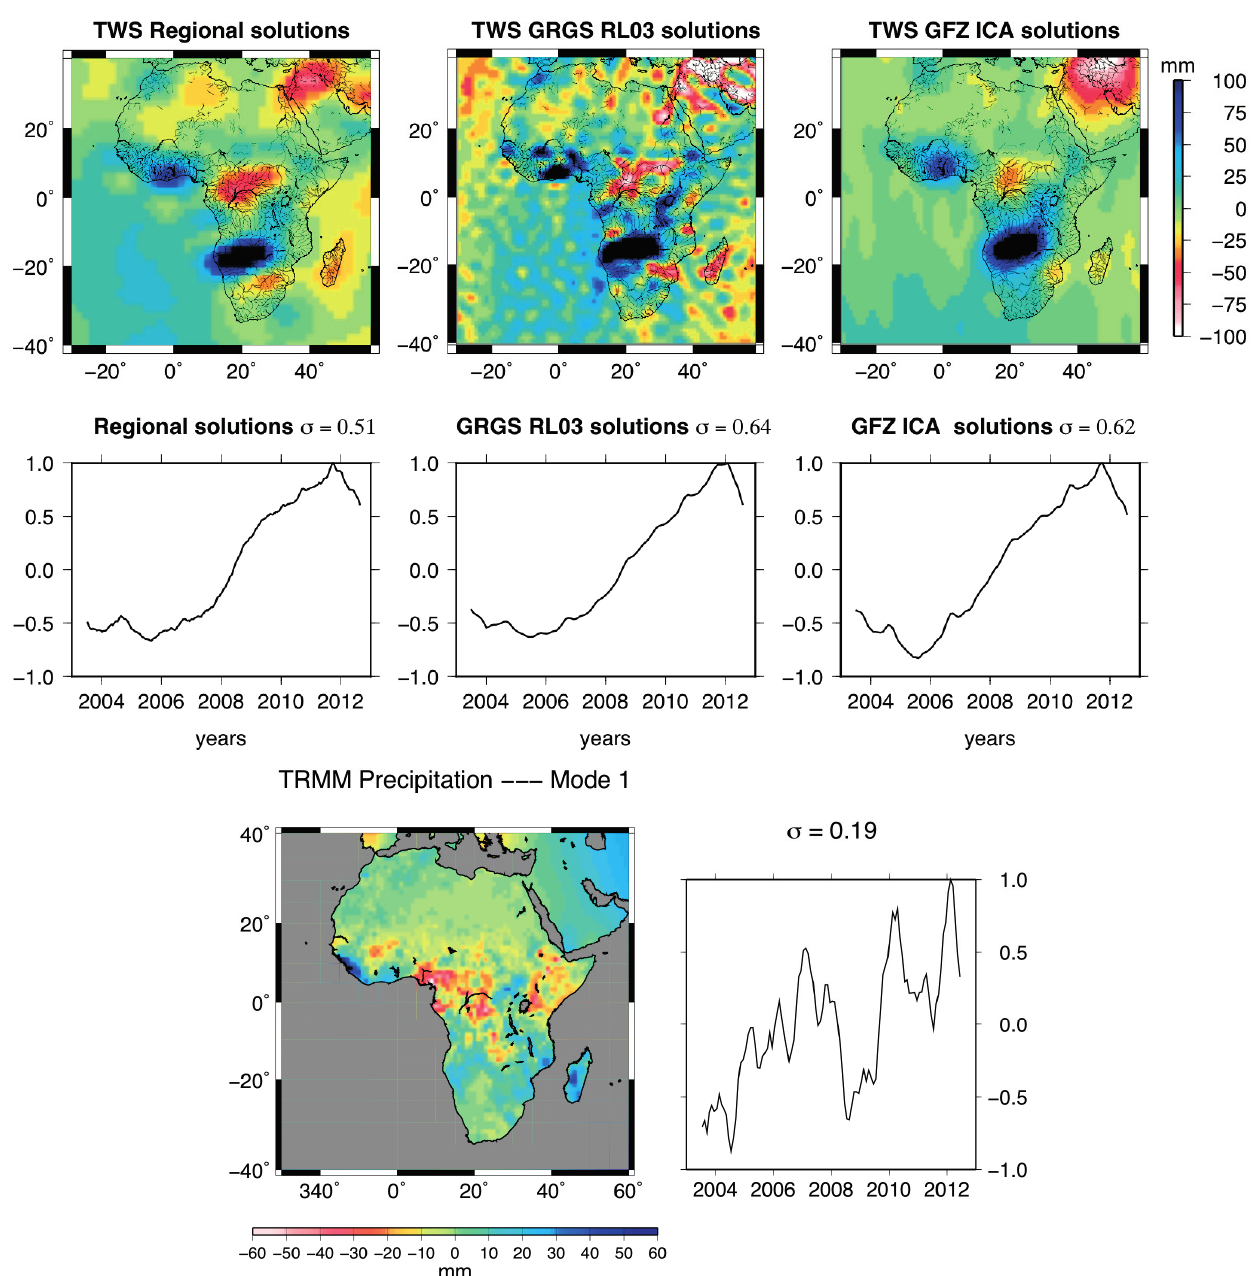
Figure 7. The first spatial and temporal modes of principal component analysis (PCA) of the regional, global GRGS and 400-km ICA GRACE solutions ( top ). The corresponding linear trends of the precipitation from TRMM for comparison ( bottom